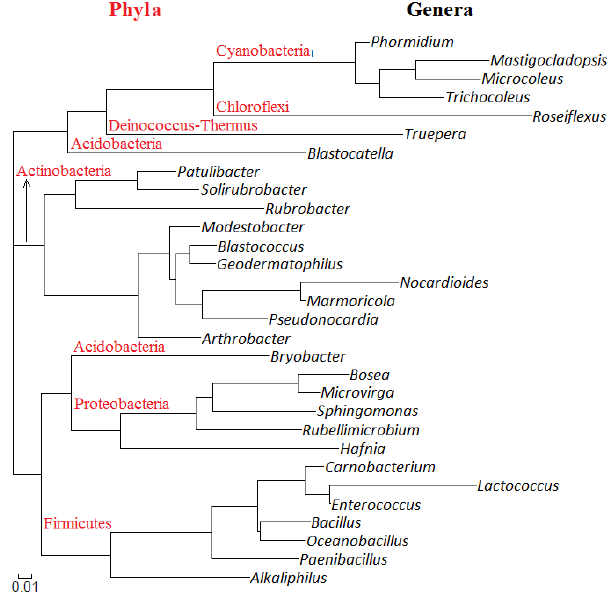
Figure 7. Phylogenetic relationship of the 30 most abundant genera in bacterial composition of